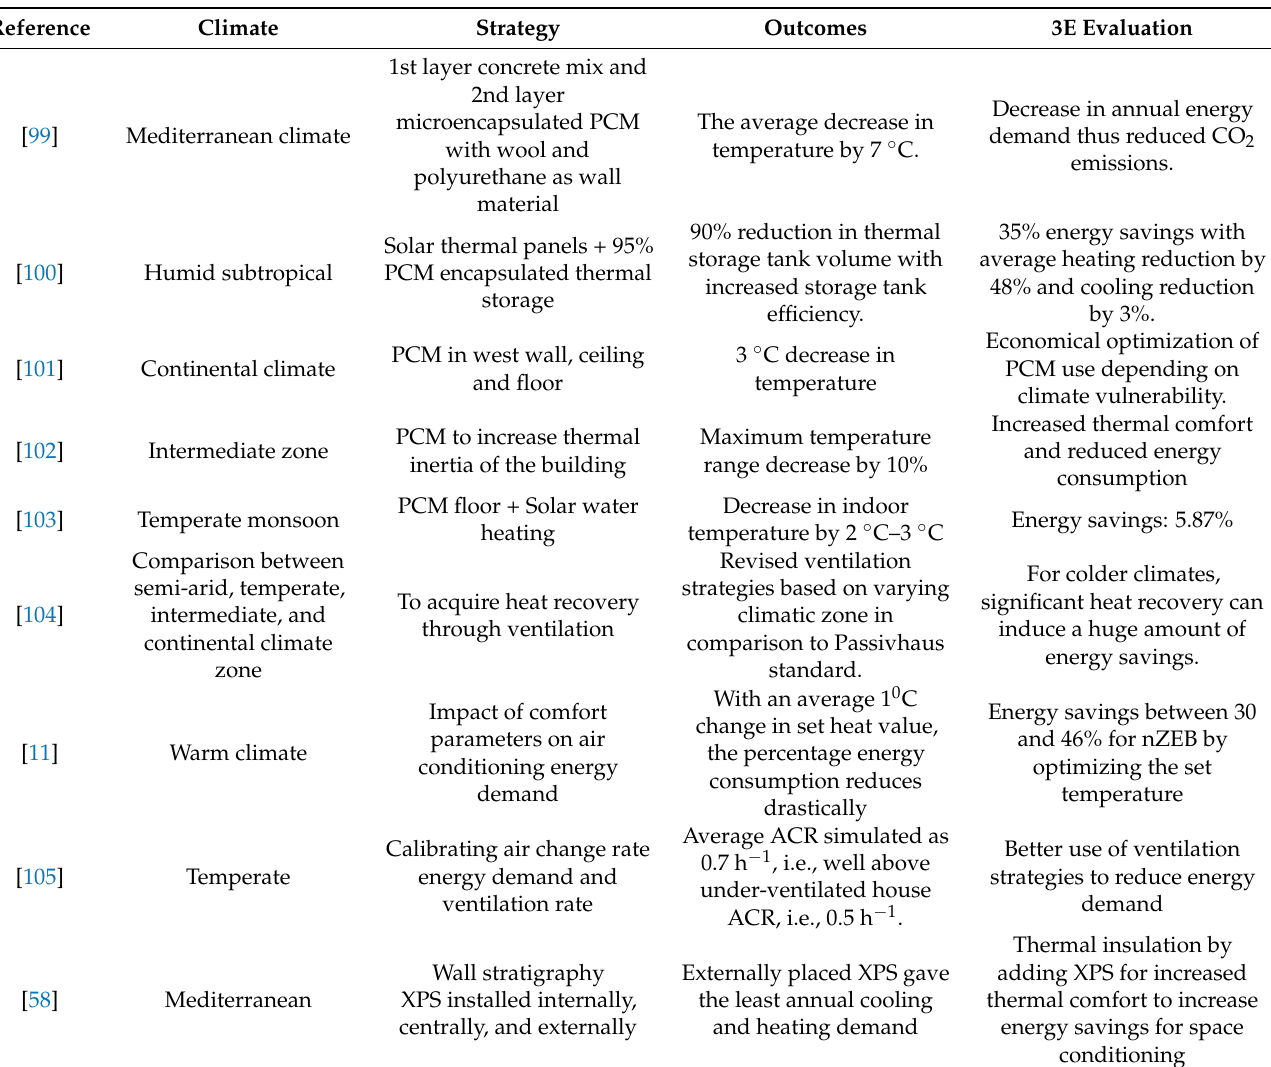
Table 4. 3E evaluations of Passive